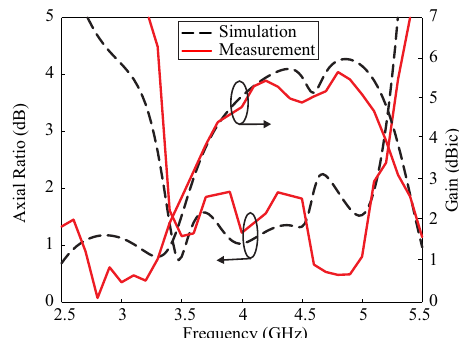
Figure 8. Simulated and measured axial ratios and left-handed circular polarization (LHCP) gains of the proposed antenna.